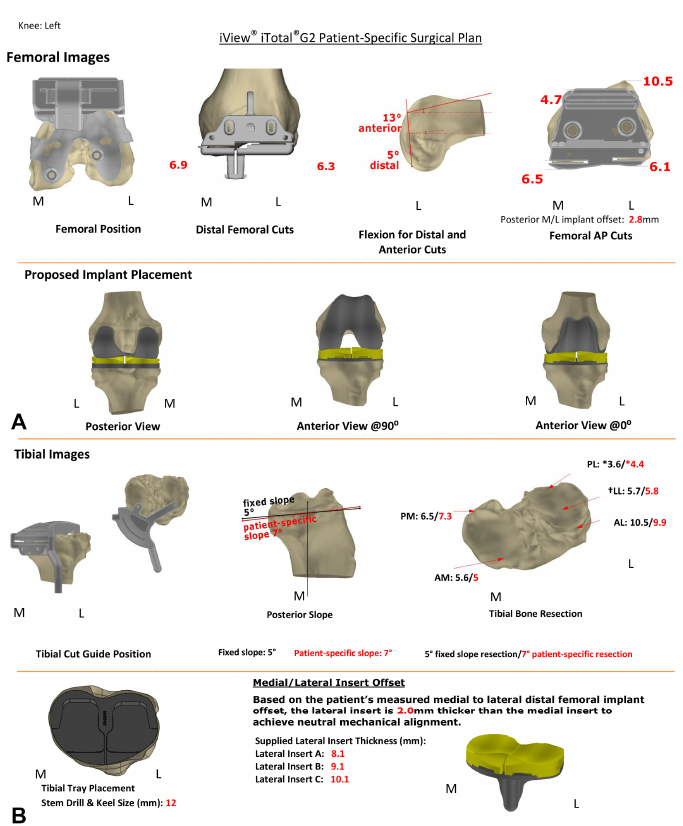
Figure 2. Representative patient-specific surgical plan (iView ® ). Upper images ( A ) show the positioning of the respective drill guide, cutting jigs, and implant for femoral preparation, and the projected thickness of the cut bone is given in red for self-control. Lower images ( B ) show the positioning of the respective cutting jig and implant for tibial preparation, and the projected thickness of the bone cut is given for self-control. Please note that a fixed cut of 5 ◦ slope (black numbers) or a patient-specific slope cut guide (here 7 ◦ ; red numbers) can be chosen, and asterisks (*) indicate a point 5 mm from